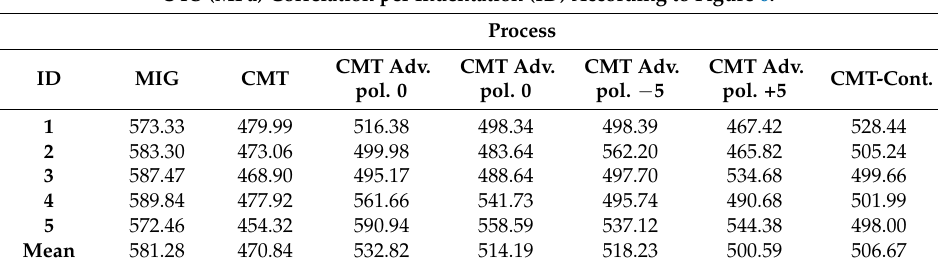
Table 5. Estimation of Ultimate Tensile Strength values based on ASTM A370 [47]. UTS (MPa) Correlation per Indentation (ID) According to Figure 6.